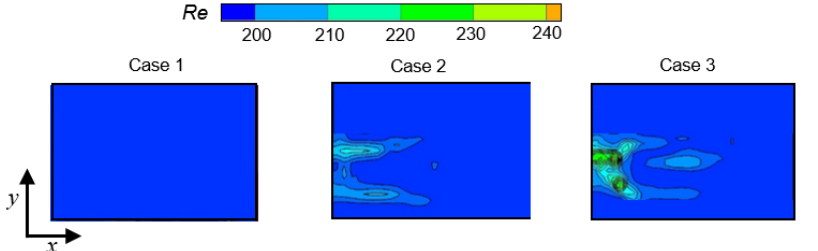
Figure 7. The High Reynolds number distribution chart displays turbulent flows in Case 1, Case 2, and Case 3.